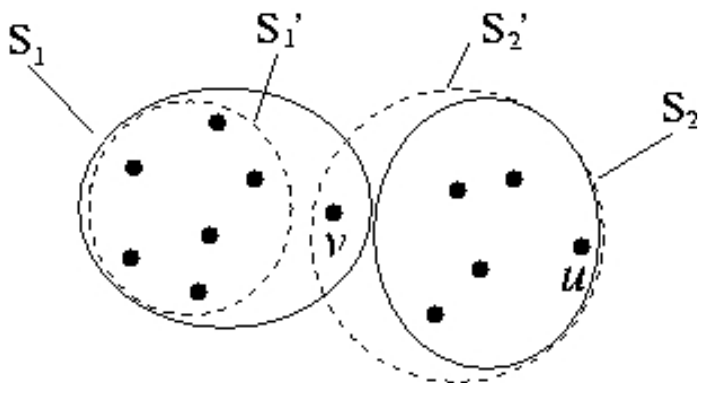
Figure 6. Proof of Theorem